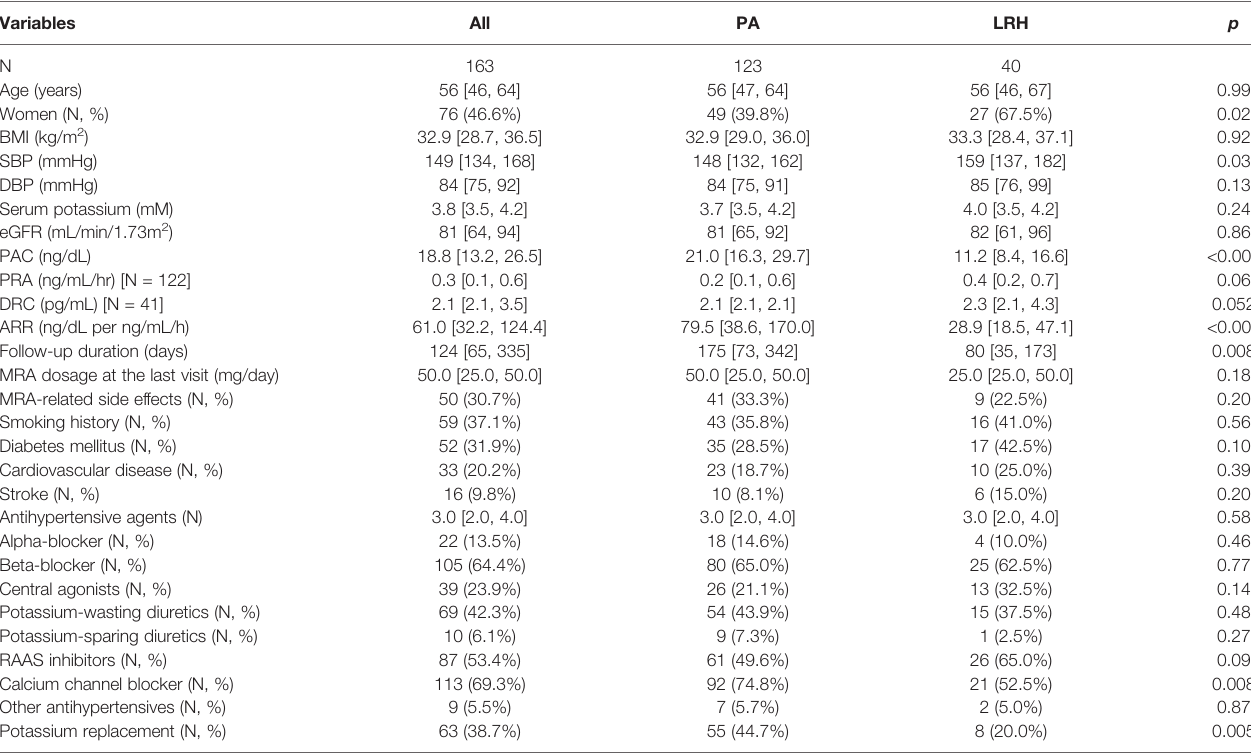
TABLE 1 | Baseline demographics of study participants. Variables